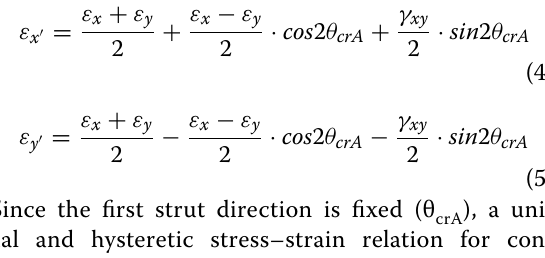
first fixed strut direction. This implies that the first crack (or strut) direction coincides with the principal stress directions in concrete, under the condition that zero shear stress develops along the crack.